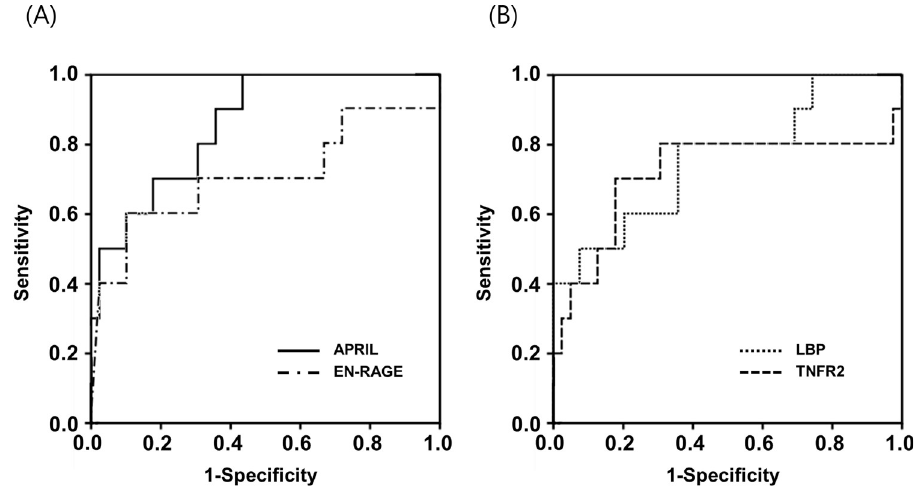
Fig 3. (A) Receiver operating characteristic (ROC) curves of amniotic fluid (AF) APRIL and EN-RAGE at predicting spontaneous preterm birth (SPTB) at < 32 weeks of gestation (AF APRIL: area under the curve [AUC] = 0.856, SE = 0.060; and AF EN-RAGE: AUC = 0.705, SE = 0.114). (B) ROC curves of AF LBP and TNFR2 at predicting SPTB at < 32 weeks of gestation (AF LBP: AUC = 0.756, SE = 0.093; and AF TNFR2: AUC = 0.715, SE = 0.118). Differences among the AUCs of AF APRIL, EN-RAGE, LBP, and TNFR2 were not significant (all variables: P = 0.09–0.73). APRIL, a proliferation-inducing ligand; EN-RAGE, extracellular newly identified receptor for advanced glycation end products binding protein; LBP, lipopolysaccharide binding protein; TNFR2, tumor necrosis factor receptor